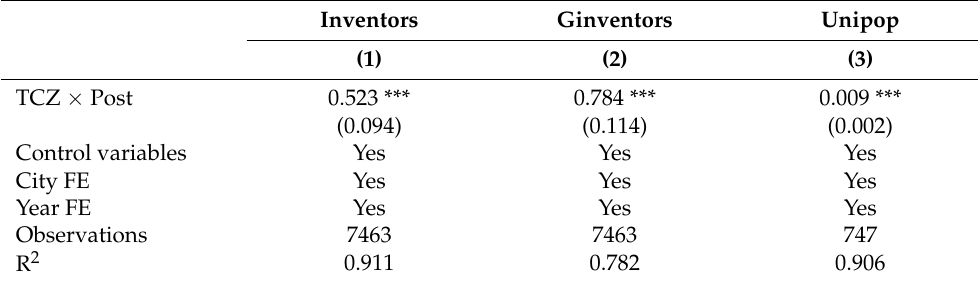
Table 6. Mechanism of human